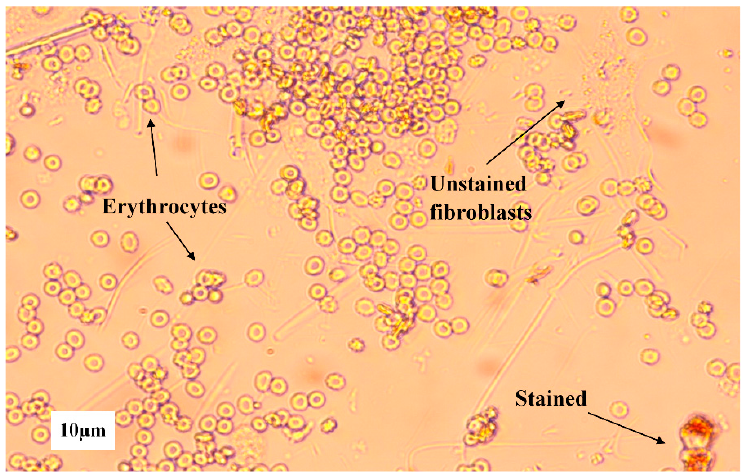
Figure 9. Different blood cells on 3T3 fibroblast cells from D2 PRF sample extract taken after 1